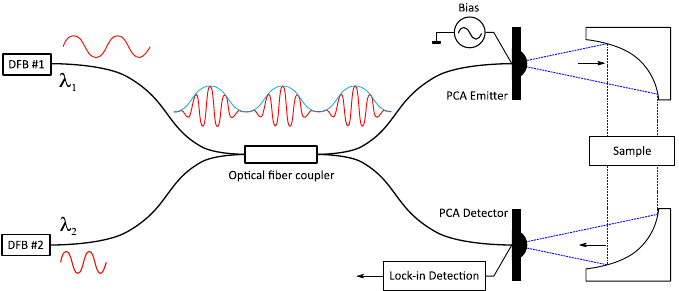
Figure 3. The structure of the Terascan 1550 THz-FDS (frequency domain spectroscopy) system. Two tunable DFB lasers were utilized for generating optical signals with different wavelengths, 𝜆 (cid:2869) and 𝜆 (cid:2870) , and mixed within the optical fiber coupler. The resulting opti- cal signal was modulated with frequency 𝑓 , which can be expressed as,